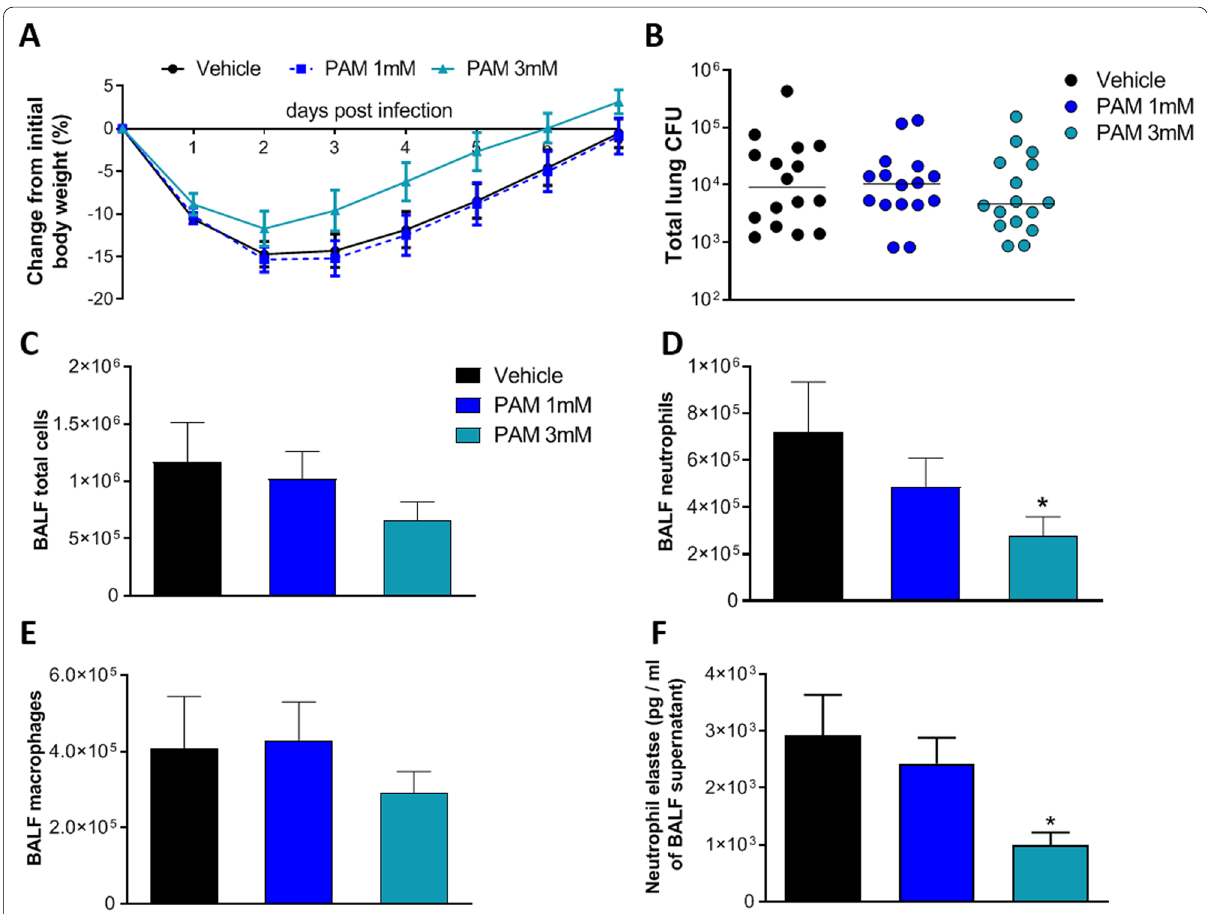
Fig. 4 Efficacy of aerosol treatment with PAM (1 mM and 3 mM) in a murine model of P. aeruginosa MDR-RP73 chronic airways infection. C57BL/6NCrlBR male mice (aged 8–10 weeks) received intratracheal inoculation with 5 10 5 CFU of MDR-RP73 strain embedded in agar beads. × Treatment started 5 min after infection, with PAM (1 mM and 3 mM) or vehicle administered via aerosol by Penn Century daily for 7 days. Before each administration, mice were weighted, and the percentage change from the initial body weight was averaged for each group of mice ( A ). Data are presented as mean SEM. At day 7 post-infection, mice were sacrificed, BALF was collected and lungs were excised and homogenized. ± BALF and lung homogenates were plated on tryptic soy agar to determine the bacterial burden ( B ). Each dot represents total CFU per lung from one mouse, and horizontal lines represent the median values. Total cell ( C ), neutrophil ( D ) and macrophage ( E ) counts were performed on BALF. Neutrophils elastase concentration was evaluated in the supernatants of BALF ( F ) by ELISA assay. Data are presented as mean SEM. Data are ± pooled from three independent experiments (n 15–16 mice). Statistical significance is indicated: *P < =